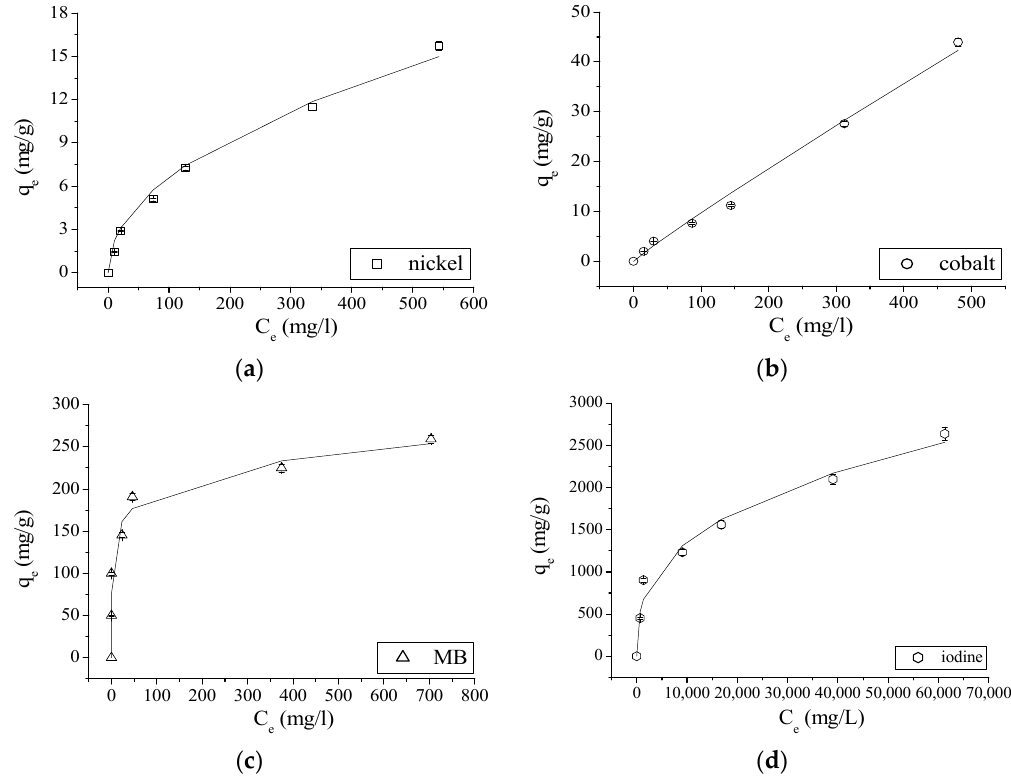
Figure 3. Adsorption isotherms for Freundlich model of: nickel ( a ); cobalt ( b ); MB ( c ); and iodine ( d ) onto GAC at 25 °C.